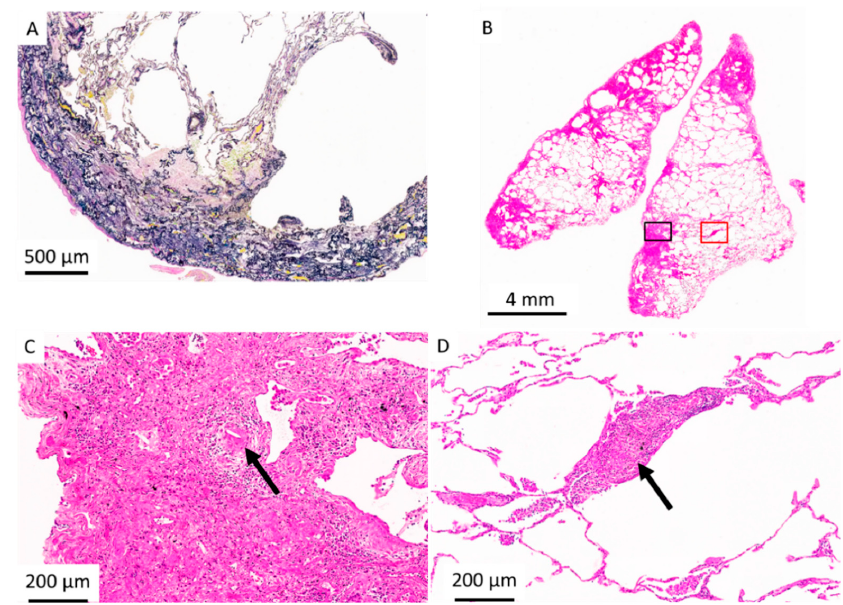
Figure 3. Surgical lung biopsy specimen from two different sites in a patient with PPFE with hy- persensitivity pneumonitis. ( A ) High-magnification photomicrograph of a left-upper-lobe biopsy specimen shows subpleural fibroelastosis (Elastic van Gieson staining). ( B ) Panoramic view of a left-lower-lobe biopsy specimen shows subpleural and paraseptal predominant fibrosis (Hematoxylin and eosin staining). ( C ) High-magnification photomicrograph of subpleural fibrosis (black square in Figure 2B) illustrates fibroblastic foci, mononuclear inflammatory cells, and a giant cell with choles- terol cleft (arrow) (hematoxylin and eosin staining). ( D ) High-magnification photomicrograph of red square in Figure 2B illustrates poorly formed non-necrotizing granuloma (arrow) and lymphocytic infiltration around a respiratory bronchiole (hematoxylin and eosin